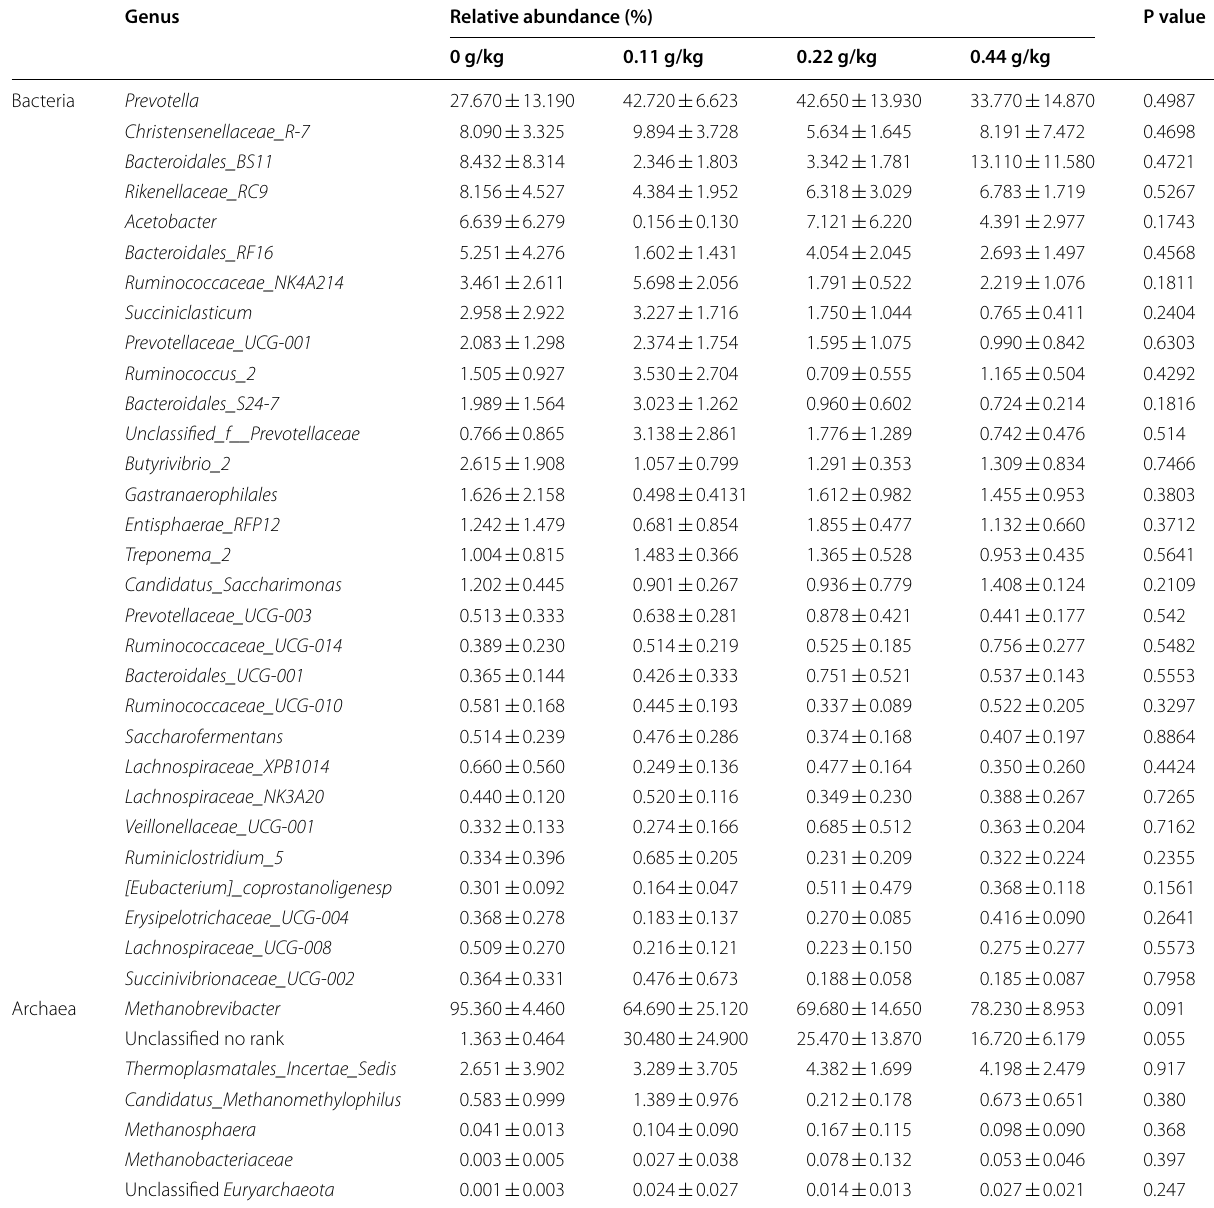
Table 8 Effects of sodium nitrate on average relative abundance of rumen microbial microbiota (% of total sequences) at the genus level in water buffaloes (n =